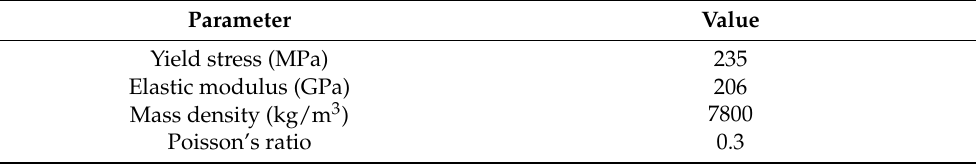
Table 1. Material constants of tower members.